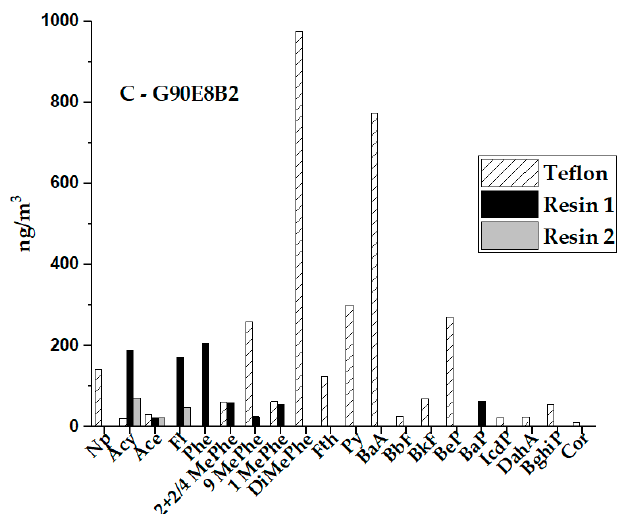
Figure 4. ( A ): Polycyclic aromatic hydrocarbon (PAH) concentrations for each fuel as a function of the trap system. ( B , C ): Distribution of PAH according to their volatility as a function of the trapping system .